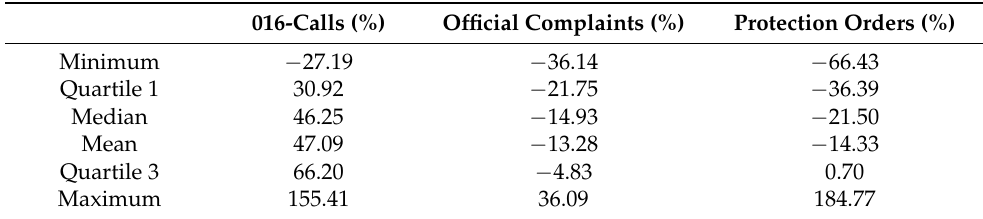
Table 2. Descriptive figures for percentage variations in 016-calls, official complaints, and protection orders for intimate partner violence against women between the second quarter of 2020 and Q2 2019 by Spanish province. 016-Calls (%) Official Complaints (%) Protection Orders (%) Minimum − 27.19 − 36.14 −